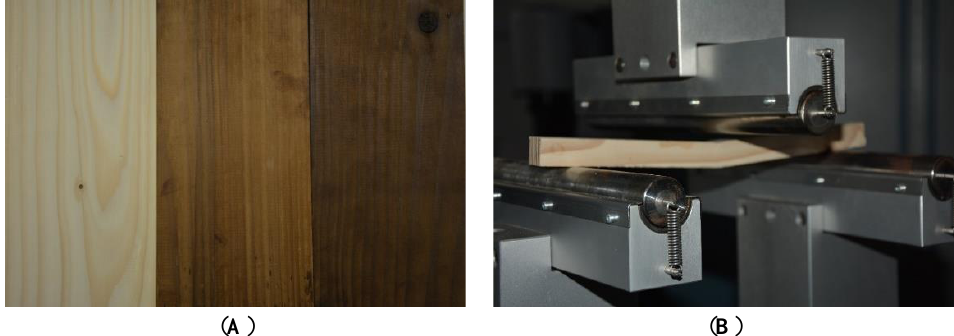
Figure 1. Laboratory experiments. A — the effect of thermal modification on brightness (left to right: Reference, 180 °C, and 200 °C). B — determination of the modulus of rupture.